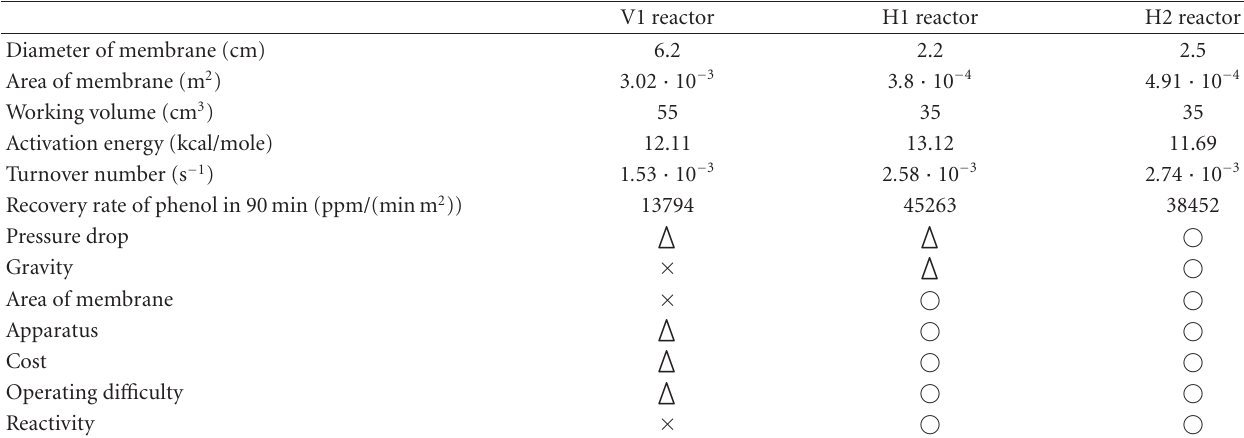
Table 1: Advantages and disadvantages of three